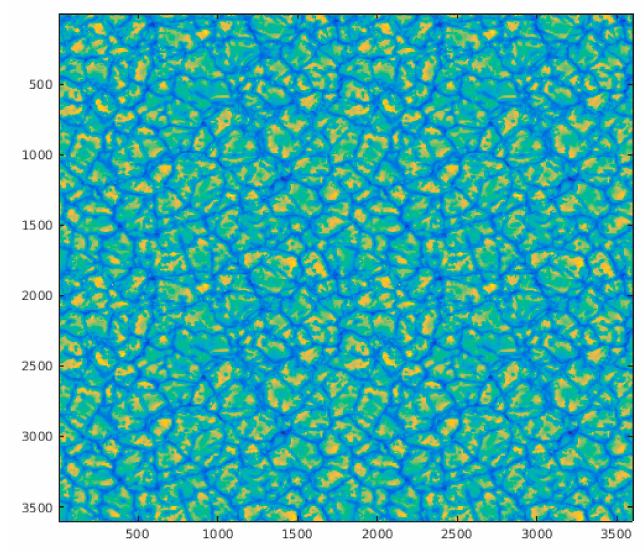
Figure 5. Full solar image used for simulation in DASP. The simulated telescope uses a determined frame of this image as scientific target.